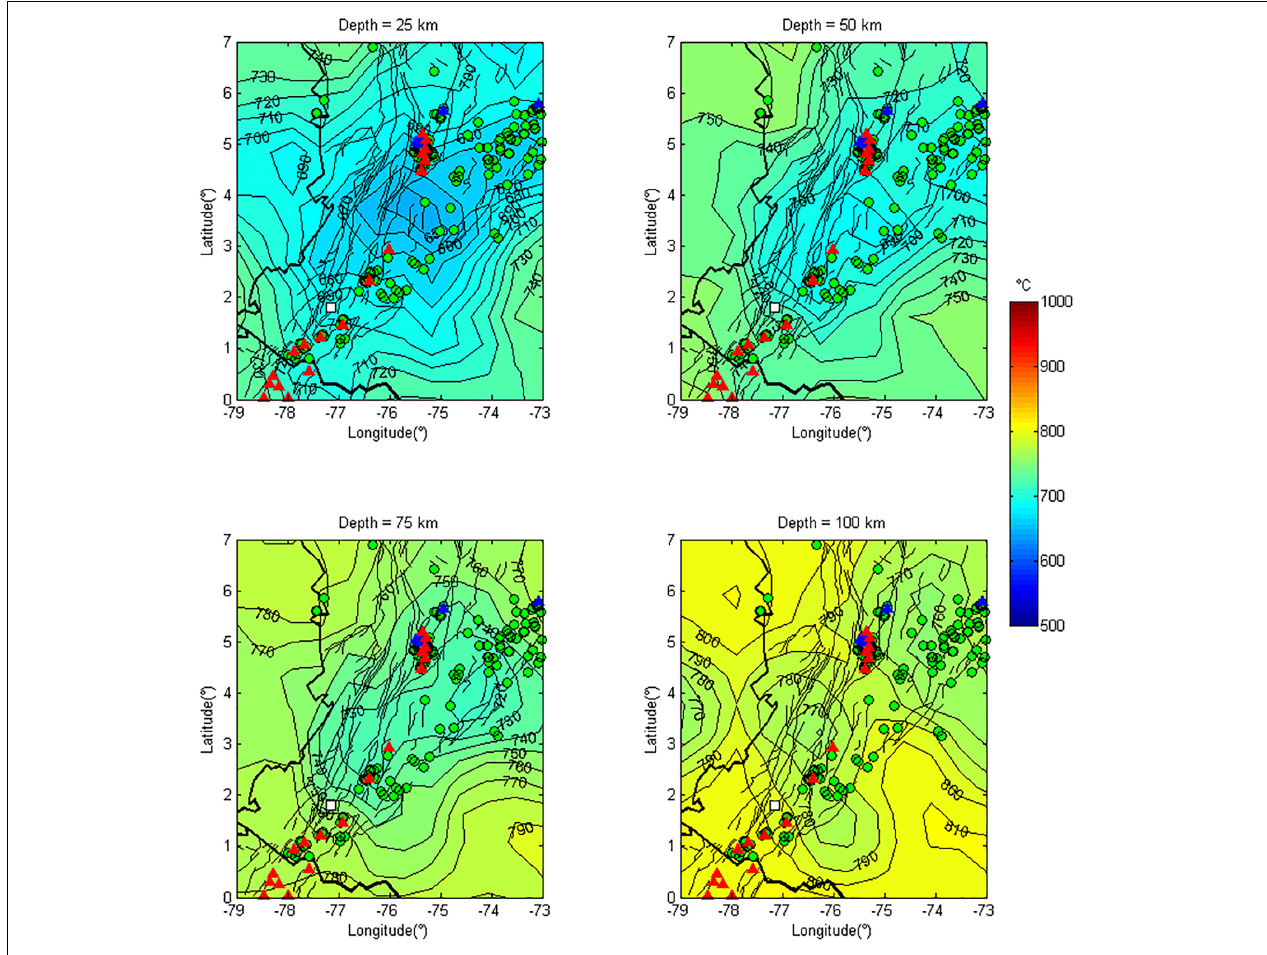
FIGURE 7 | Estimations of the thermal structure for four of the eight slices presented in the attenuation tomography. The isotherm distribution in the volcanic arc of the Northern Andes suggests the presence of a low-intensity thermal anomaly, which matches with a zone of lack of active volcanism, also surrounded by spring water occurrences. The white square symbol corresponds to the localization of the xenoliths reported by Weber et al.